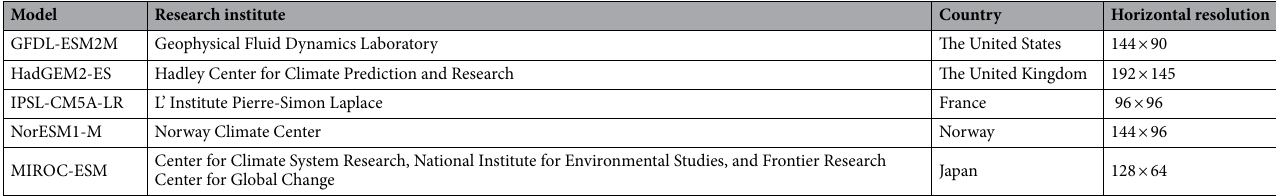
Table 1. Basic information of 5 ESMs in CMIP5. Horizontal resolution means the number of longitudinal grids × the number of latitudinal grids.